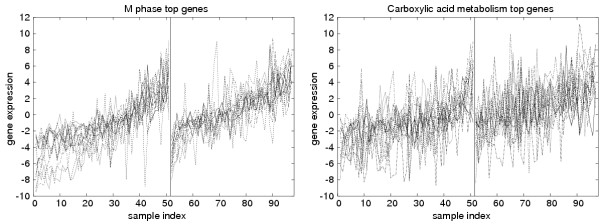
Effects of coexpression on different null hypotheses. Expression profiles, over the 97 samples in van 't Veer et al. [13], of the 12 most highly ranked genes in the "M phase" category (left) and 13 most highly ranked genes in the "carboxylic acid metabolism" category (right), respectively. Some genes were inverted since the ranking was based on absolute correlation values to metastasis class. The metastasis free samples are to the left of the vertical line, and within each metastasis class, samples are ordered in increasing average expression of the examined genes. The expressions of each gene was normalized to zero average across samples. The narrower band of expressions in the left figure illustrates the higher Pearson correlation of M phase genes. Average absolute Pearson correlation between gene expressions was 0.74, with standard deviation of 0.16, for the M phase genes, and 0.44, with standard deviation of 0.27, for carboxylic acid metabolism genes.